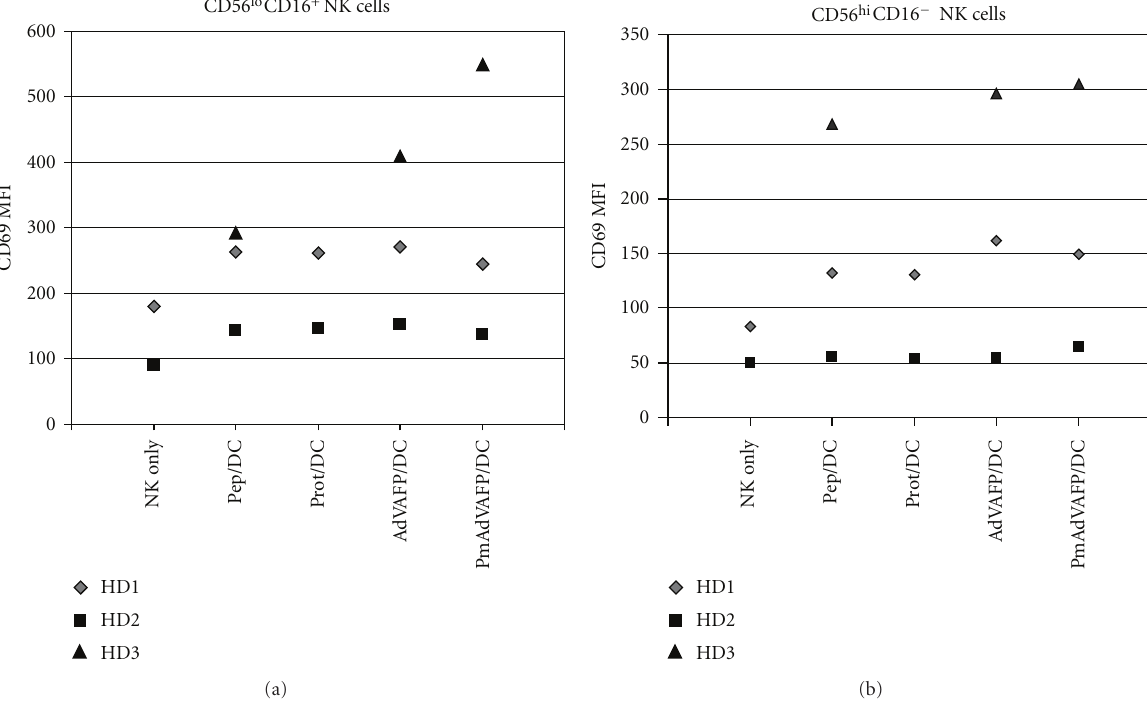
Figure 3: CD69 expression on healthy donor CD56 hi and CD56 lo CD16 + NK cells. Phenotyping of NK cells from HD PBMC after 48hr coculture with di ff erent DC groups, showing CD69 upregulation on the (a) CD56 lo CD16 + and (b) CD56 hi CD16 − subsets for three